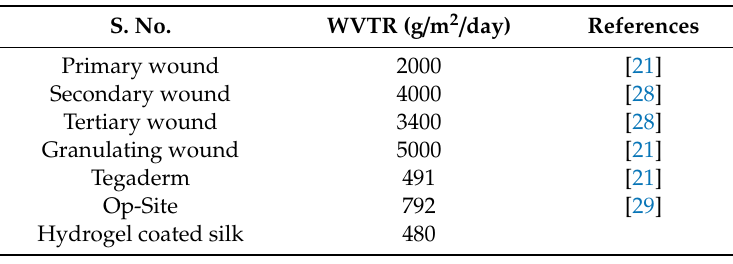
Table 3. WVTR of di ff erent types of wound and di ff erent commercially available dressings.